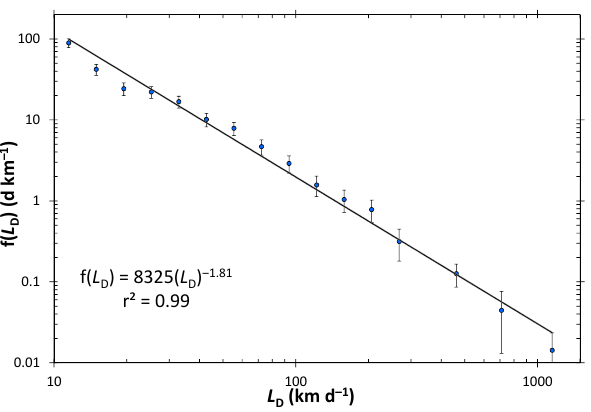
Fig. 15. The frequency-length statistics of continental USA daily tornado outbreaks during the period 1982–2011. The frequency densities f( L D ) are given as a function of L D , the total path length of all severe tornadoes ( L ≥ 10km) during a USA daily outbreak. Daily values are for convective days (12:00–12:00 UTC). Vertical error bars represent ±2 σ (±two standard deviations) and calculated as given in Fig. 10 caption. The best-fit power-law correlation of the data is also given (Eq. 17). Tornado path length data L are from NOAA (2012).